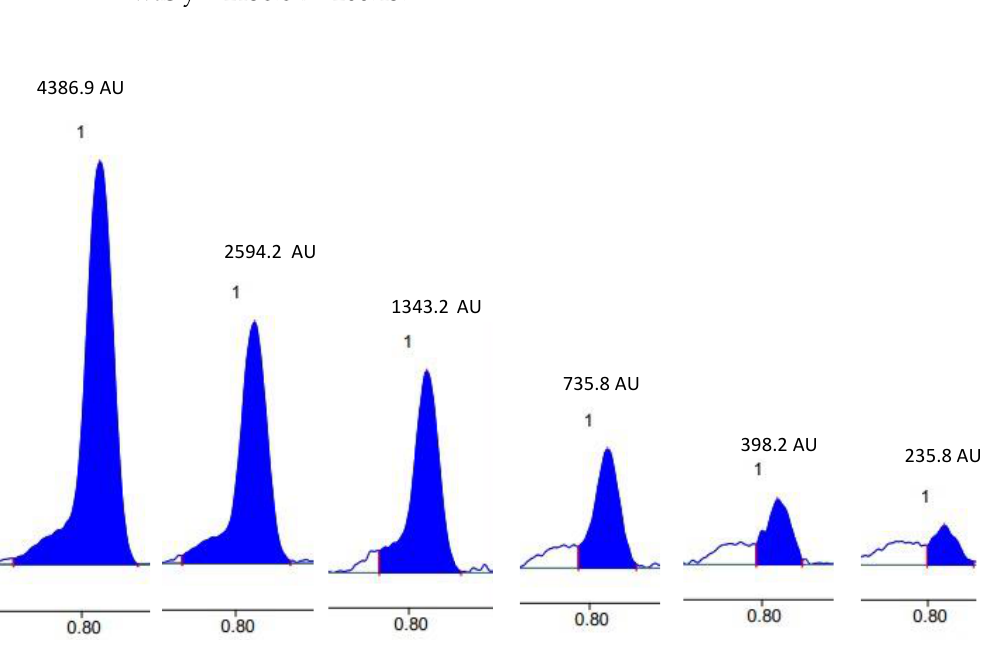
Figure 12. Densitograms of the reference soyasapogenol obtained at 6 different concentrations after visualization with anisaldehyde-H 2 SO 4 and SS2 development, which were used to calculate the calibration curve.